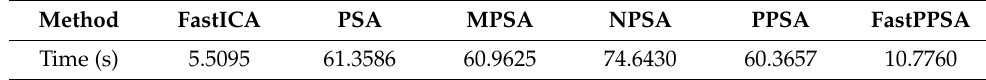
Table 15. SCNR comparison of target 2.